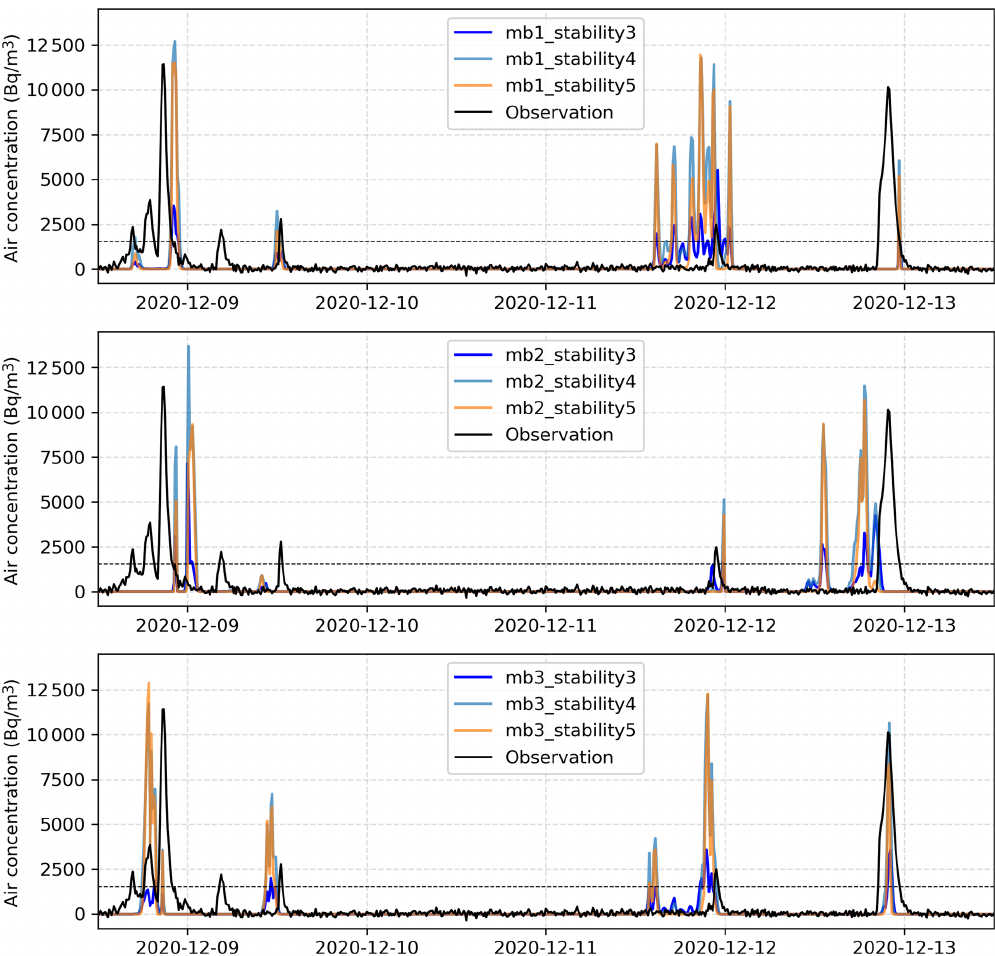
Figure 12. The same experiments as in Fig. 9, but with three stationary stability classes of Pasquill: 3rd, 4th, and 5th class; mb1, mb2, and mb3 denote, respectively, each of the three members of pX ensemble